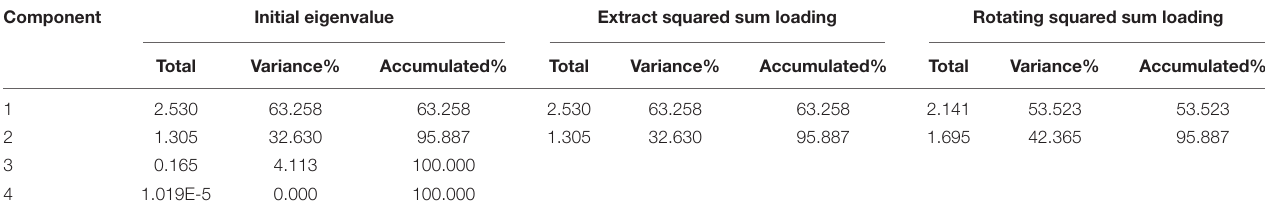
TABLE 13 | Total variance of interpretation.